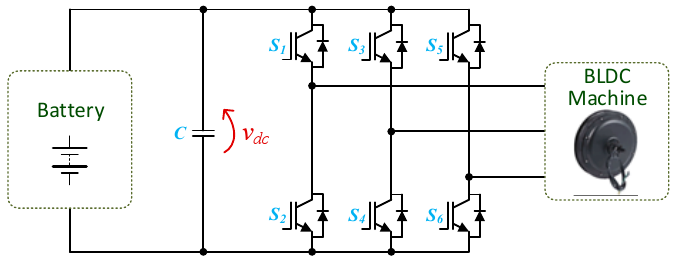
Figure 40. Traction system for an electric bicycle based on a brushless direct current (BLDC)